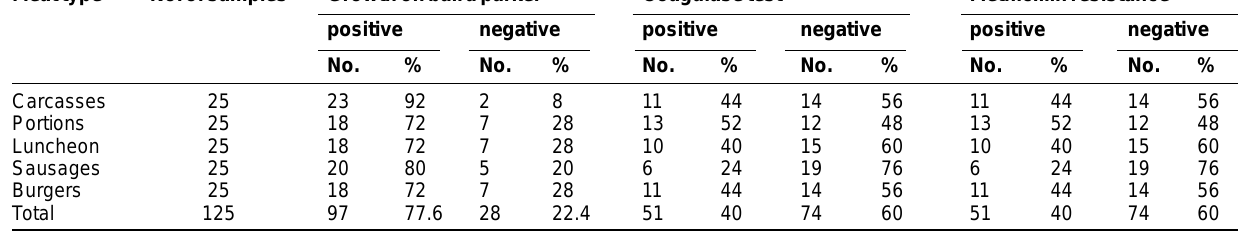
Figure-1. Prevalence Rate of MRSA in poultry meat and poultry